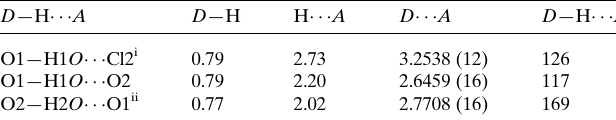
Table 1 Hydrogen-bond geometry (A˚ , (cid:2) ).